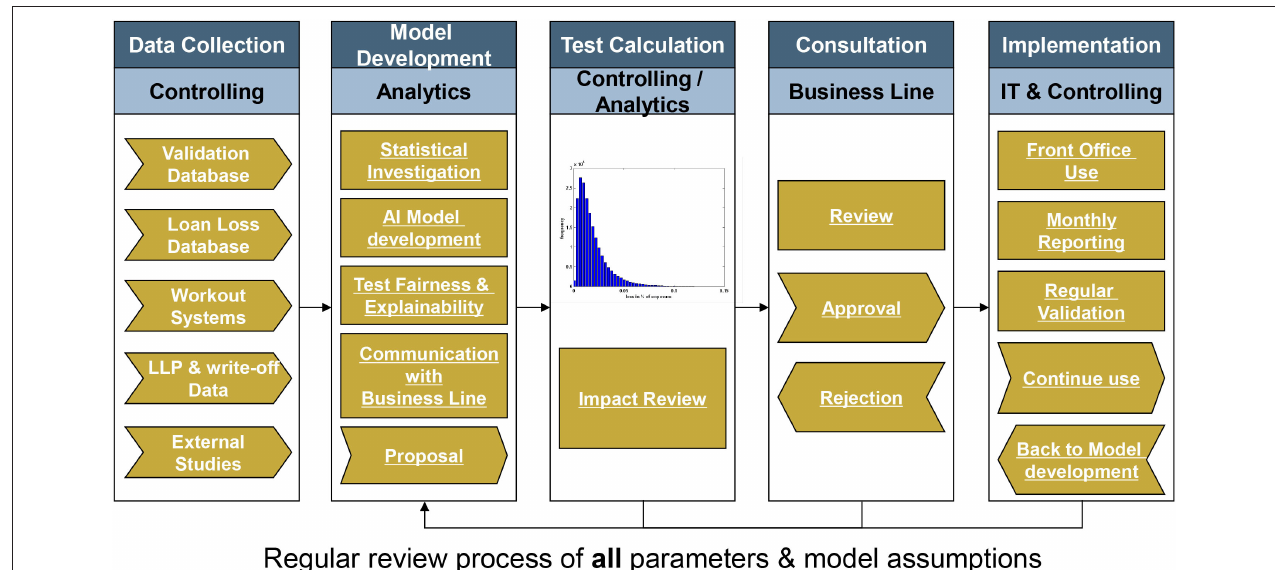
FIGURE 1 | Simplified flowchart for a model development, application and validation